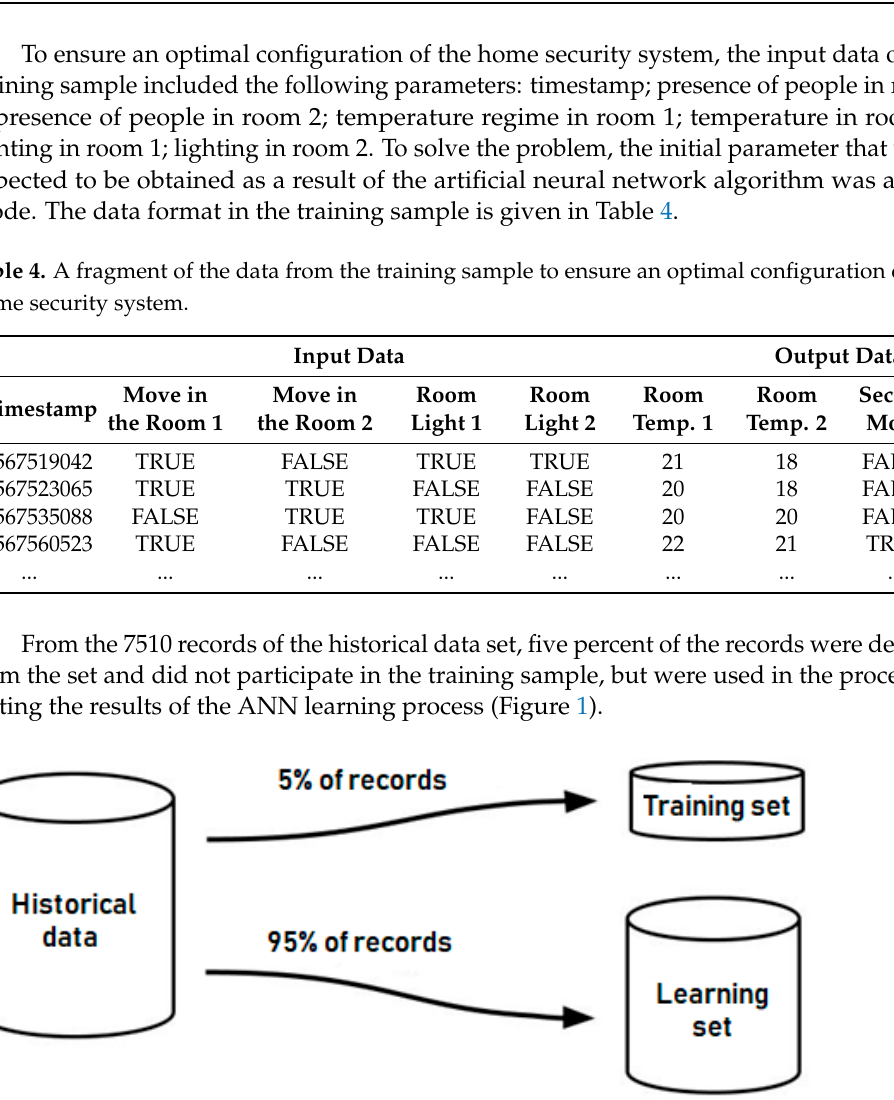
Table 4. A fragment of the data from the training sample to ensure an optimal configuration of the home security system.